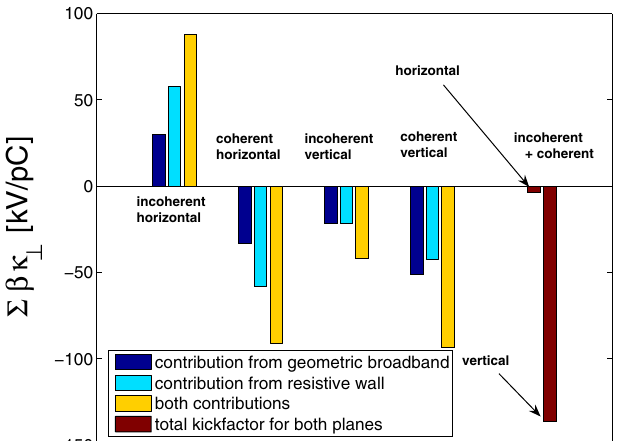
FIG. 17. (Color) Measured and calculated vertical detuning ver- sus single bunch current at 8 MV and 11 MV rf voltage, measured thresholds slightly below 0.7 mA. Normalization of the betatron tune shifts on the zero current synchrotron tune (cid:11)